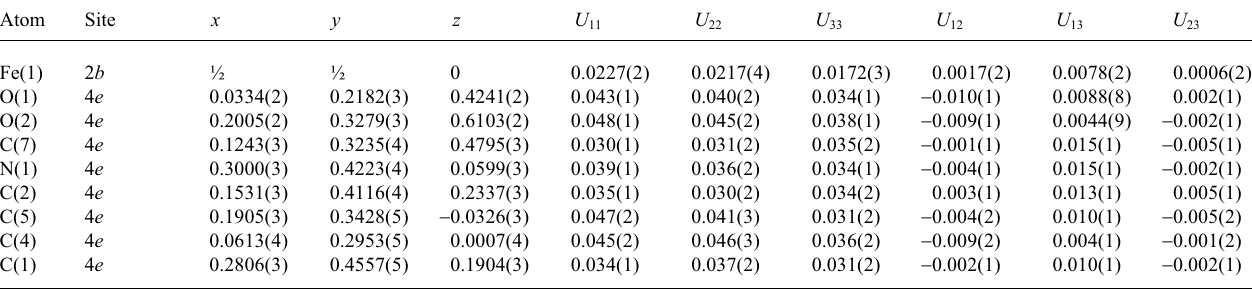
Table 3. Atomic coordinates and displacement parameters (in Å 2 ).